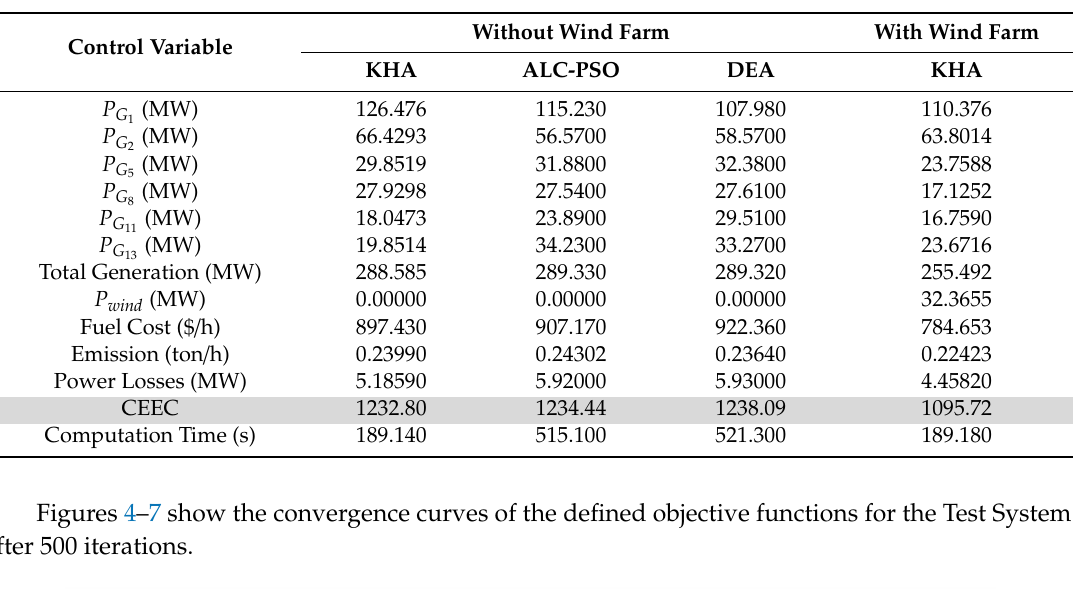
Table 7. Results for emission minimization for the Test System 1.